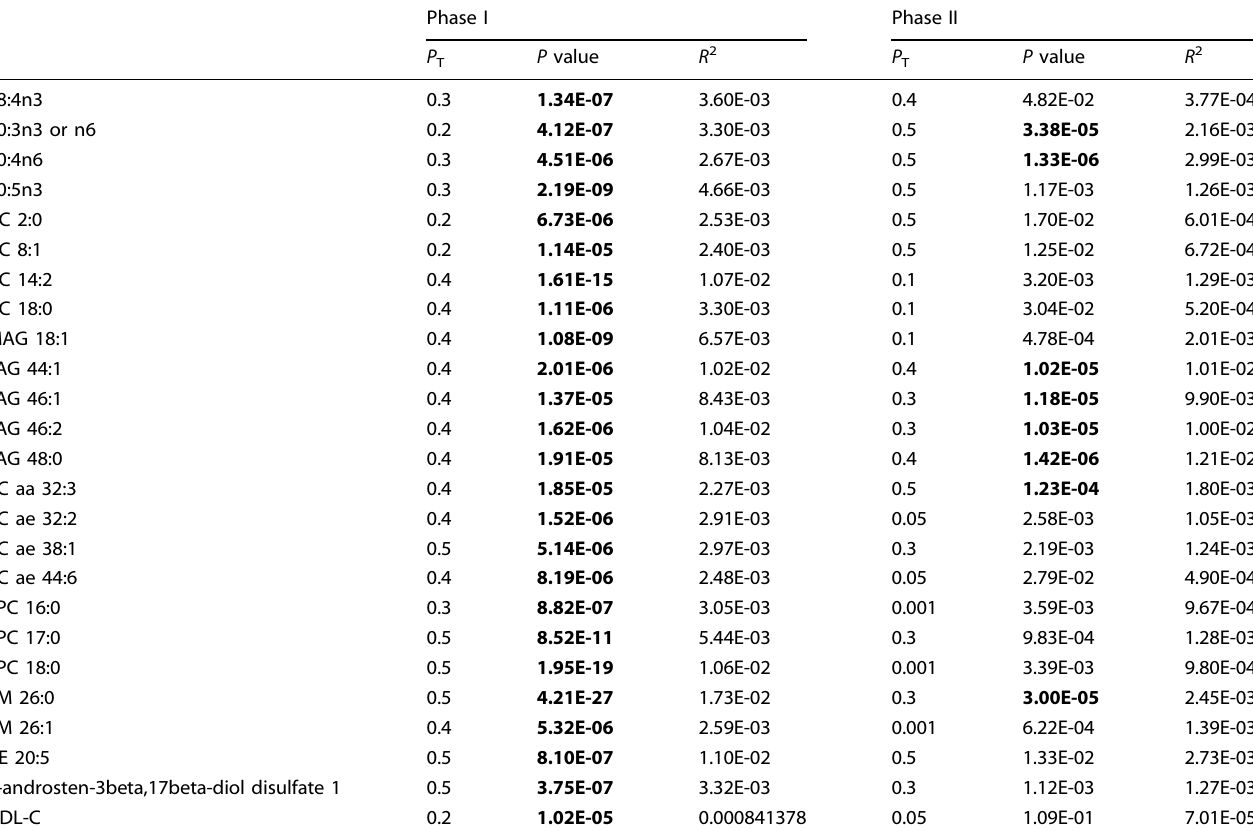
Table 2. Corroboration of the genetic overlap between PD and the blood levels of 25 lipids displaying signi fi cant genetic sharing with PD in phase I. Phase I Phase II